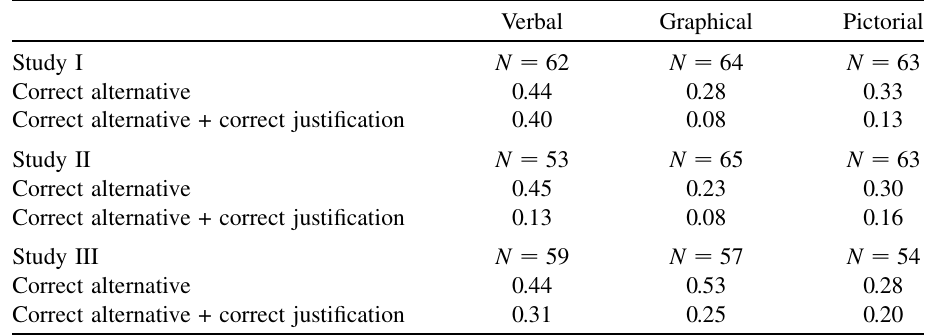
TABLE I. Fraction of students answering correctly, broken down by representational format, for the different problem variants.